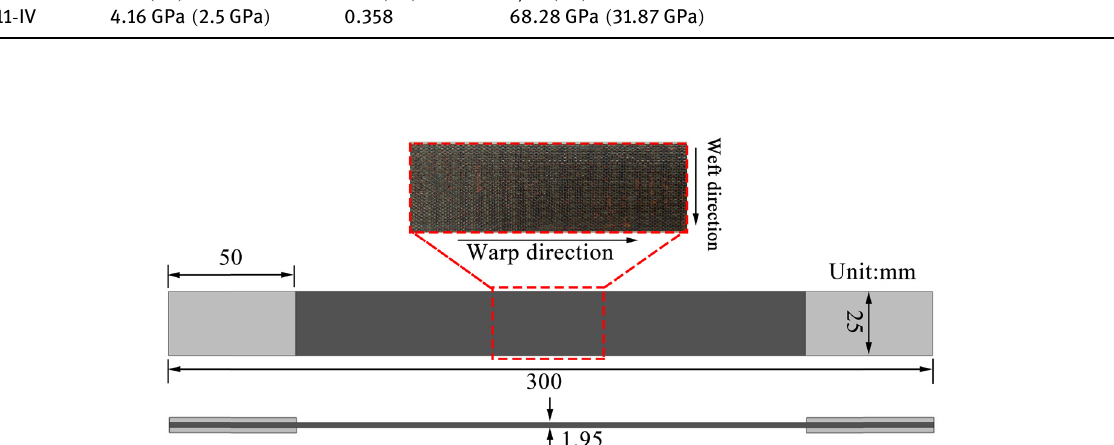
Table 2: Woven parameters of 2.5D woven composites [ 30 ]